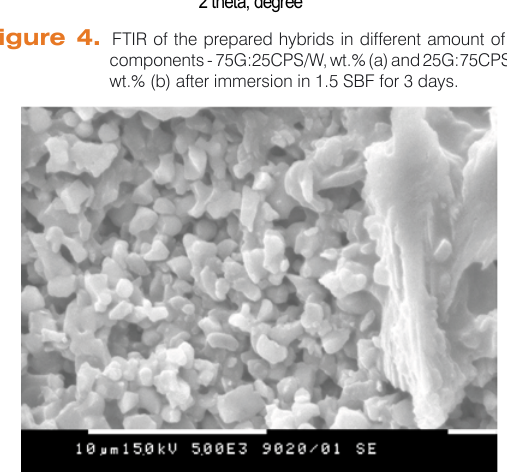
Figure 7. SEM of the synthesized 75G:25CPS/W (wt.%) before immersion in 1.5 SBF.